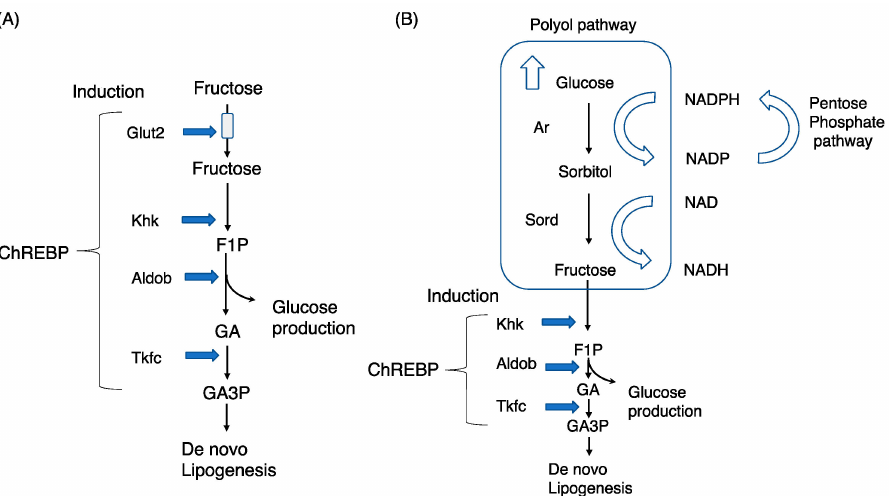
Figure 1. Chrebp regulates exogenous and endogenous fructose metabolism in the liver. ( A ) Ex- ogenous fructose metabolism: fructose is transported into the cytosol via Glut2 (liver) and is then converted into fructose-1-phosphate (F1P), glyceraldehyde (GA), and GA3P via ketohexokinase (Khk), aldolase b (Aldob), and triokinase/FMN cyclase (Tkfc), respectively. ( B ) Endogenous fructose metabolism: the polyol pathway comprises aldose reductase (Ar) and sorbitol dehydrogenase (Sord). Excess glucose is converted into sorbitol and fructose via Ar and Sord, respectively. Fructose is similarly converted into F1P, GA, and